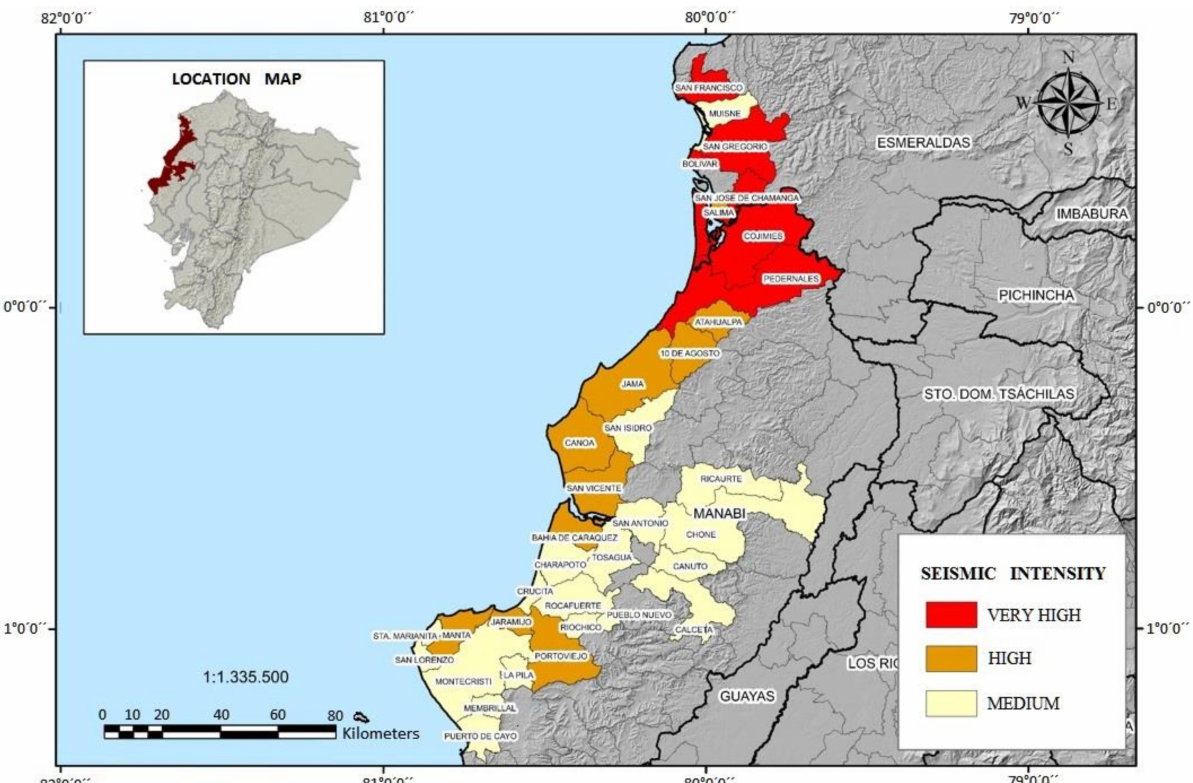
Figure 1. Seismic intensity map by parish. Source: Department of Risk Management